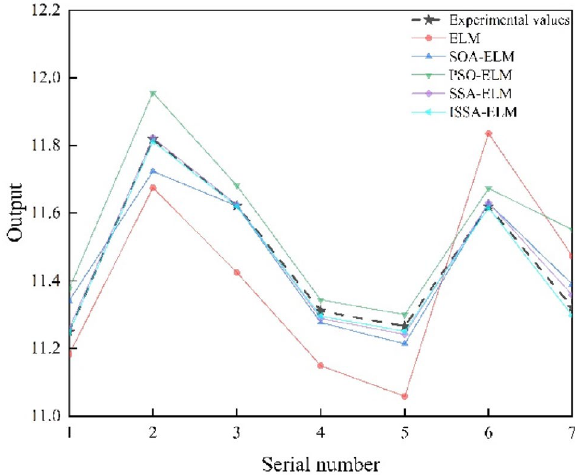
Figure 10. Predicted versus desired output for each